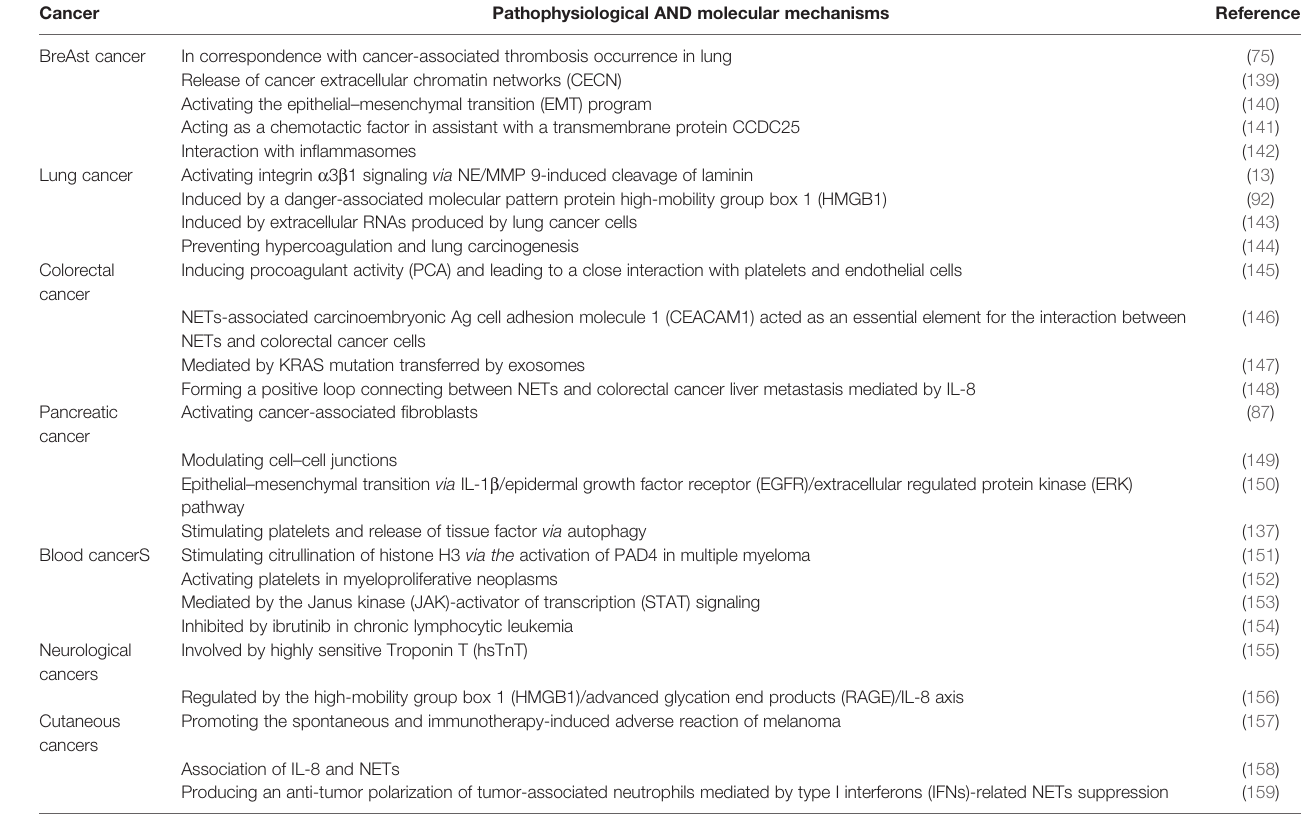
TABLE 1 | Potential pathophysiological and molecular mechanisms of NETs on different kinds of cancers. Cancer Pathophysiological AND molecular mechanisms Reference BreAst cancer